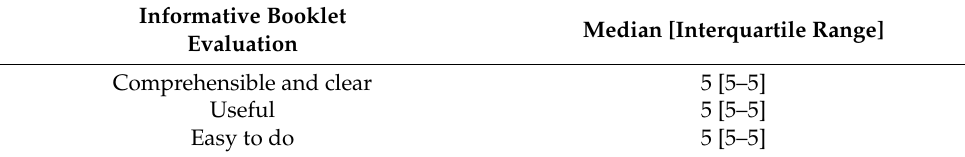
Figure 5 . Dentists ‘evaluation of children’s behavior . The difference in children’s behavior assessed by parents between the study group (median: 4; IQR: 3–4) and the control group (median: 4; IQR: 2.25–4) was not statistically significant ( p = 0.347; Mann–Whitney U test). 4. Discussion Negative, painful, and invasive experiences play a central role in the etiology of dental fear, and they often date back to childhood and adolescence. Children who had a negative experience since the first approach to the dentist have a higher risk of suffering from dental fear than children who had only a negative or painful experience after several positive experiences [14,15]. Hence, this shows the importance of setting up a structured first dental visit that activates positive experiences and nontraumatic memories. This is the first study in the literature to focus on the child’s preparation before the first dental visit. This preparation took place in a safe environment and by an affectively relevant person such as a parent informed by the booklet. Parents appreciated the information booklet considering it clear, easy to use, and truthful. Our results show that guiding parents to prepare their child for the first dental visit has a reassuring effect on